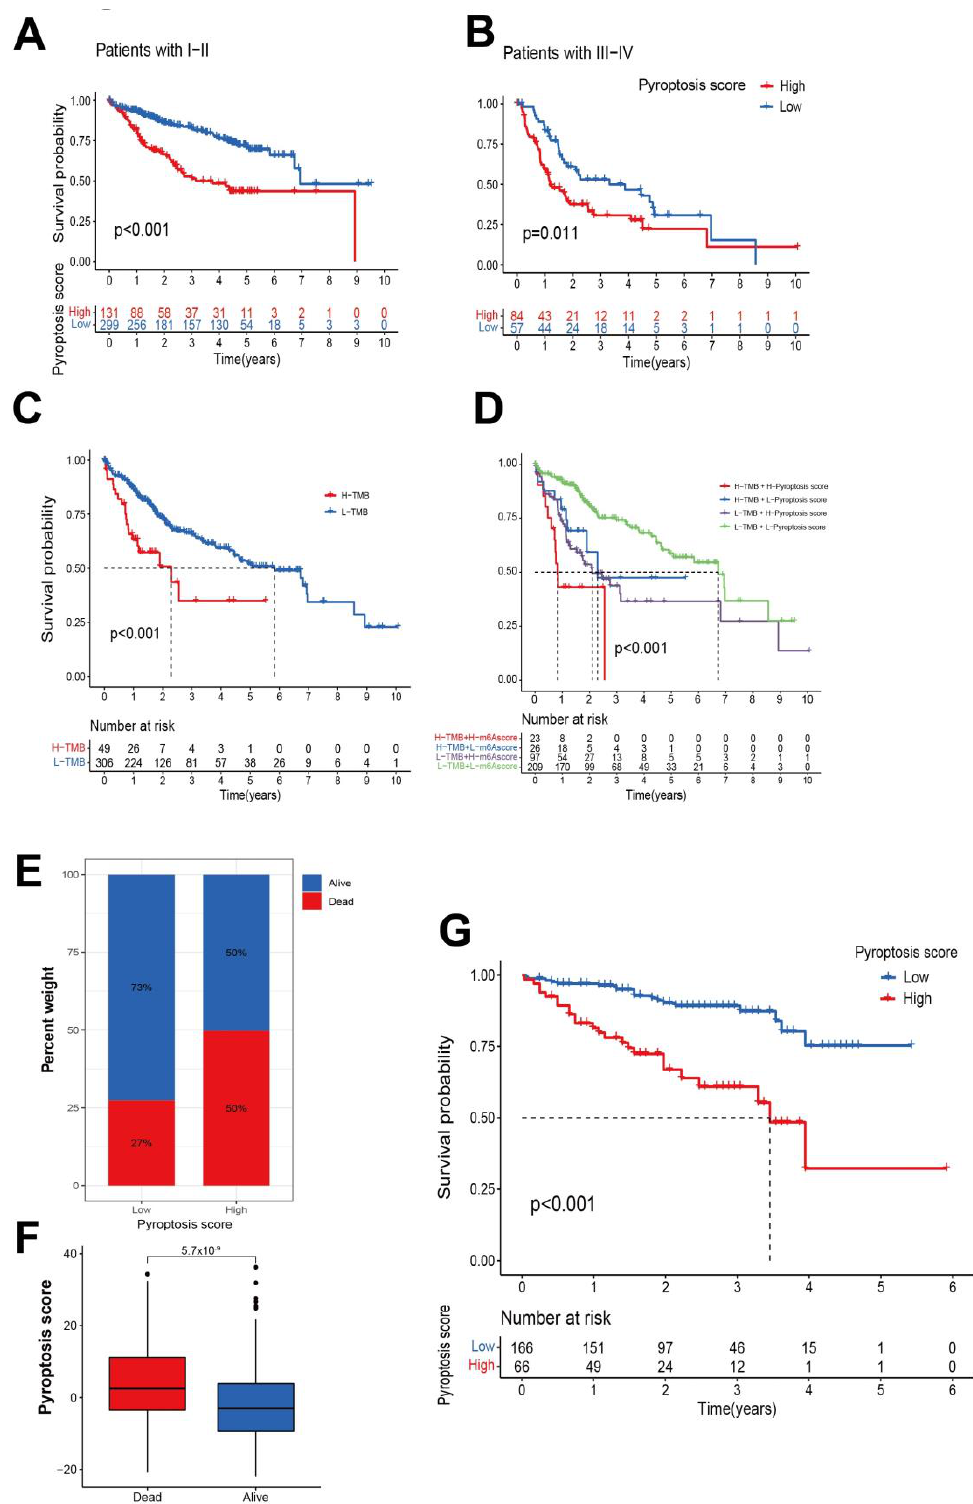
Figure 6. Clinical verification of pyroptosis scores. Overall survival analysis of patients with ( A ) TMN stage I – II and ( B ) TMN stage III – IV categorized in the high- and low- risk groups, respectively, ( C ) Overall survival analysis of high-TMB (red) and low-TMB (blue) tumors, and ( D ) tumors subdivided by the pyroptosis risk score. ( E , F ) Distribution and visualization of the follow-up of all patients in the two pyroptosis risk groups. ( G ) Further verification of the risk classification of HCC patients using external ICGC data sets.